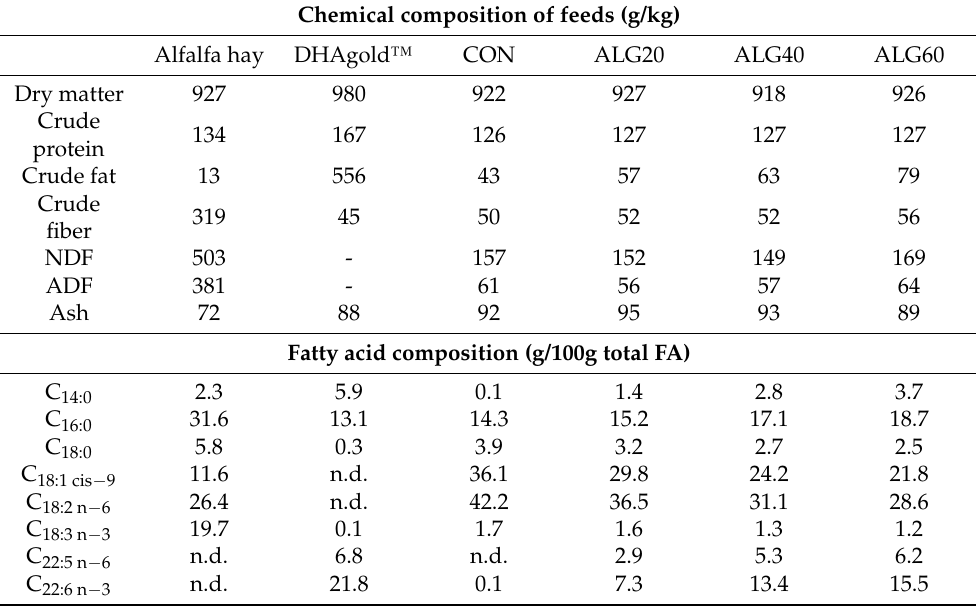
Table 1. Alfalfa hay, DHAgold™, and concentrate mix: chemical composition (g/kg) and fatty acids profile (g/100 g total fatty